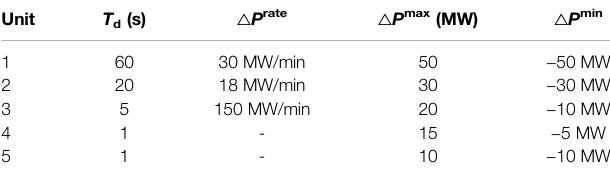
TABLE 3 | Main parameters.